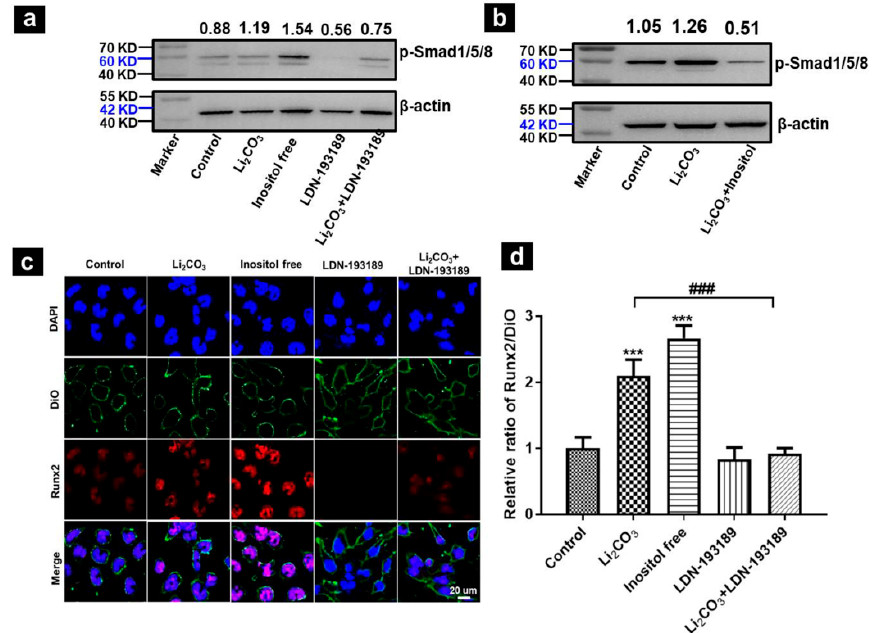
Figure 4. Activation of Smad signaling pathway in mNSCs. ( a ) Western blot of p-Smad1/5/8. ( b ) Expression of p-Smad1/5/8 after inositol (10 mM) supplementation. ( c ) Confocal images of mNSCs labeled with Runx2 antibody (red), Dio (green), and cell nucleus (DAPI, blue). The scale bar is 20 μ m for all. ( d ) Quantification result of Runx2 in ( c ). Li 2 CO 3 : 1.5 mM, LDN-193189: 1 μ M. Data are shown as mean ± SD. (n = 3; *** p < 0.001 vs. control group; ### p < 0.001, comparison between Li 2 CO 3 and Li 2 CO 3 + LDN-193189 groups).